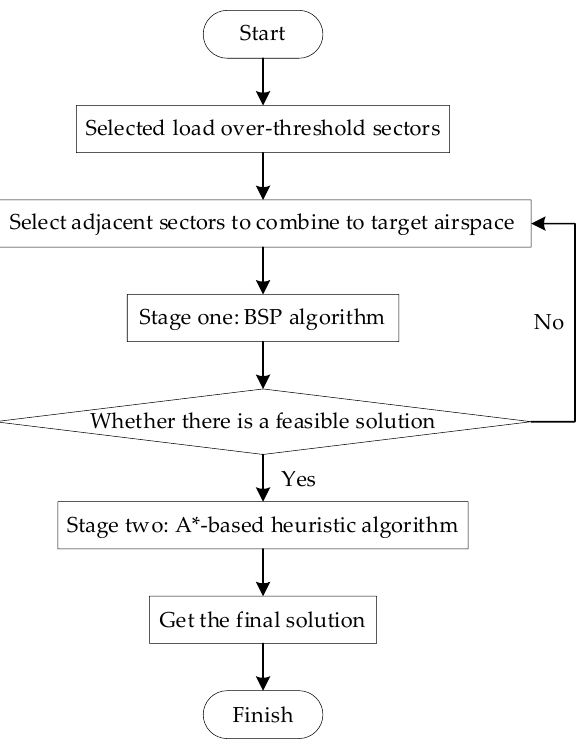
Figure 2. Flowchart of two-stage boundary generation and tuning in FRA.